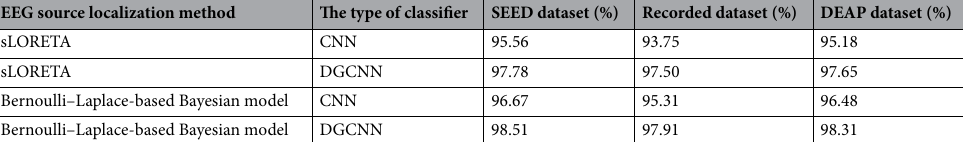
Table 5. Subject-independent classification accuracy and details of the proposed method and hybrid method and CNN classifier.